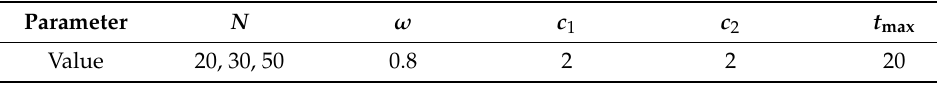
Table 6. Parameter setting in the PSO algorithm.